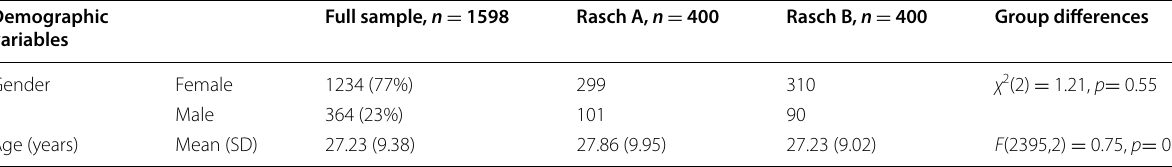
Table 1 Characteristics of the whole sample and random subsamples including tests for difference Demographic